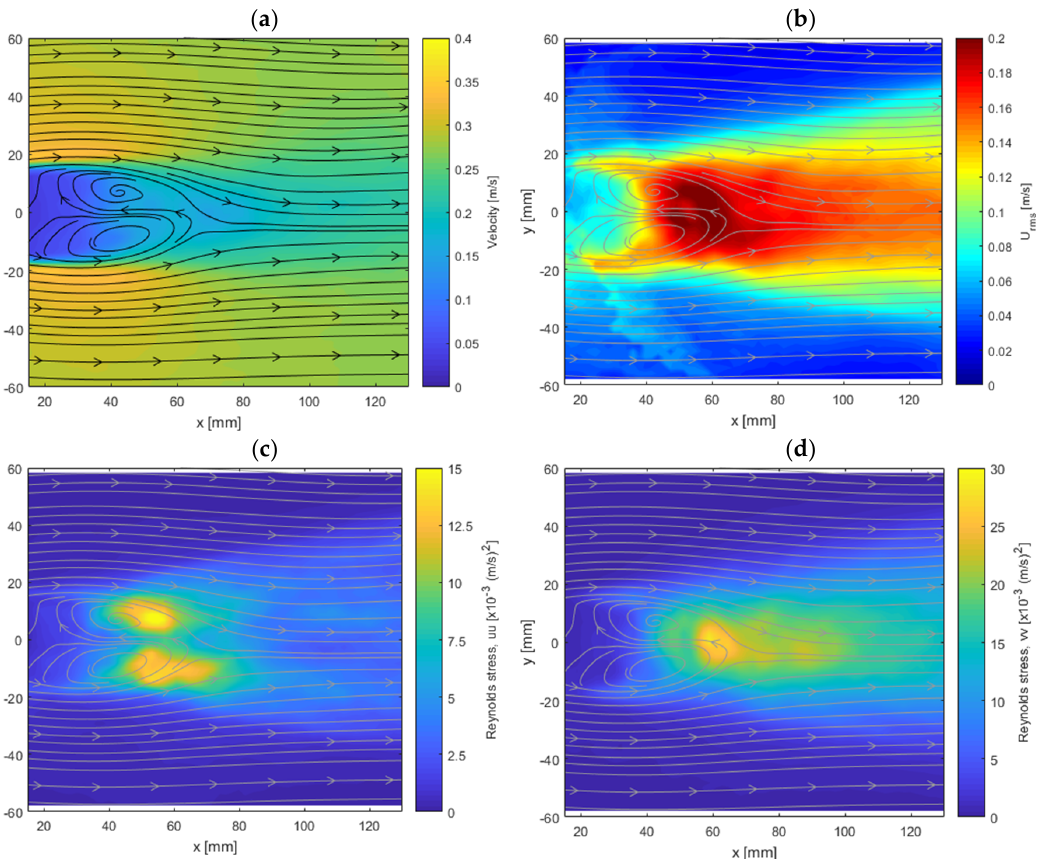
Figure 2. Test case flow field information. ( a ) Ensemble average velocity magnitude with streamlines overlaid. ( b ) Velocity total rms calculated over ensemble of snapshots. Reynolds stresses: uu ( c ) and vv ( d ). Ensemble average velocity streamlines overlaid on ( b – d ) for reference.